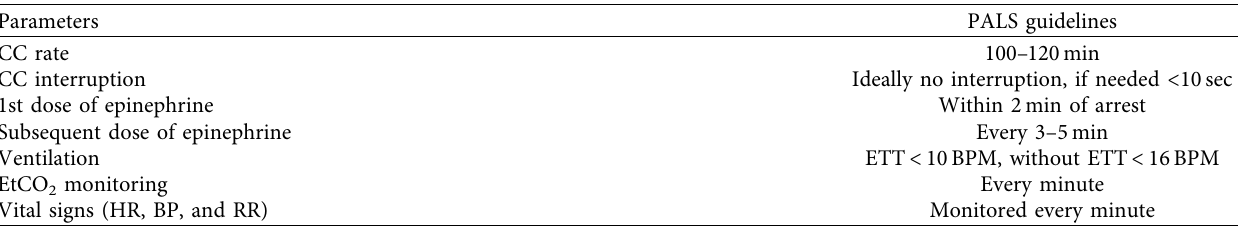
Table 1: Pediatric advanced life support (PALS) American Heart Association Guidelines for cardiopulmonary resuscitation (reference [10]).